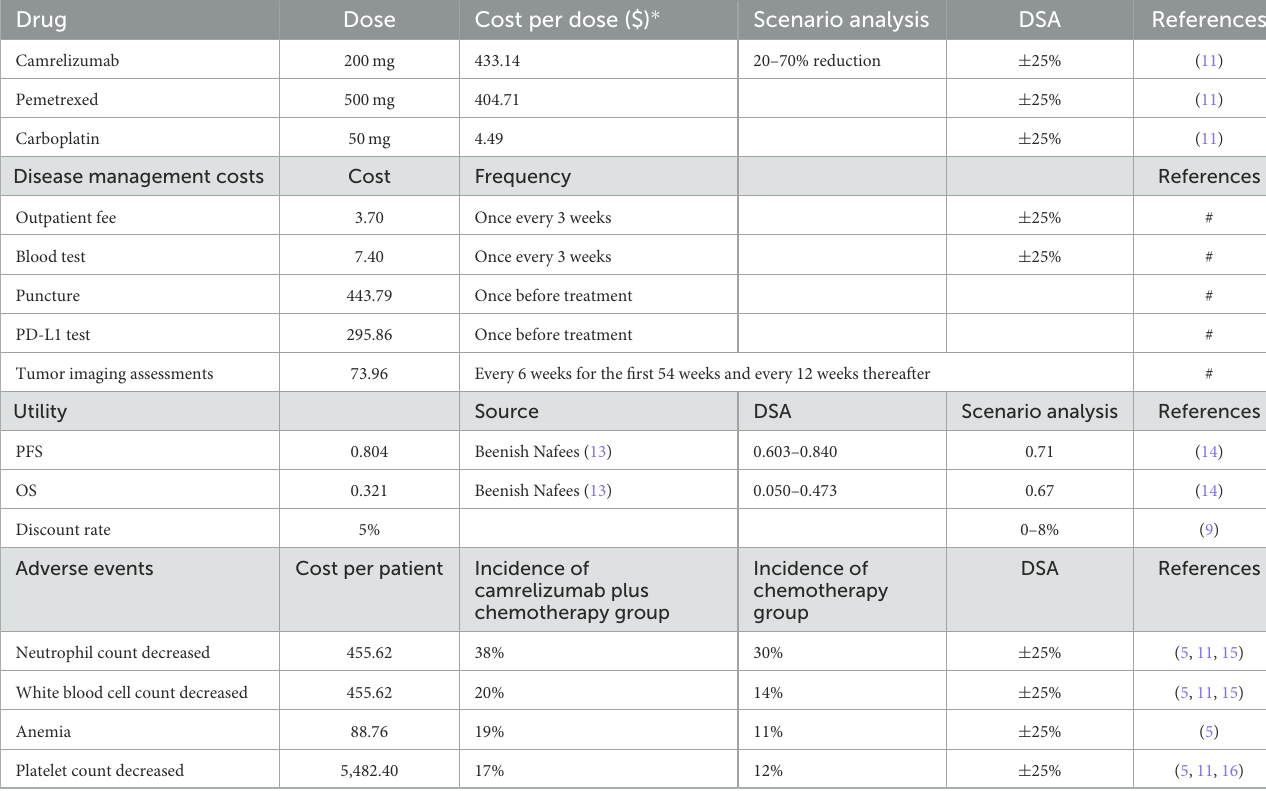
TABLE 2 Cost and utility data.